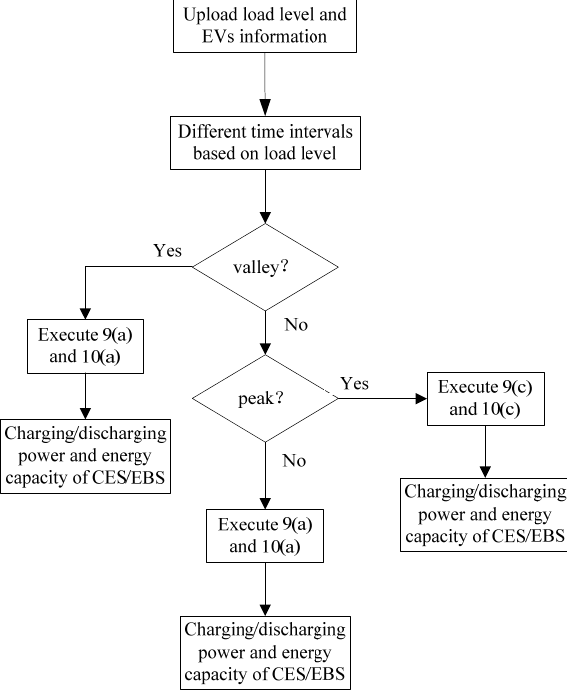
Figure 11. Charging discharging algorithm of